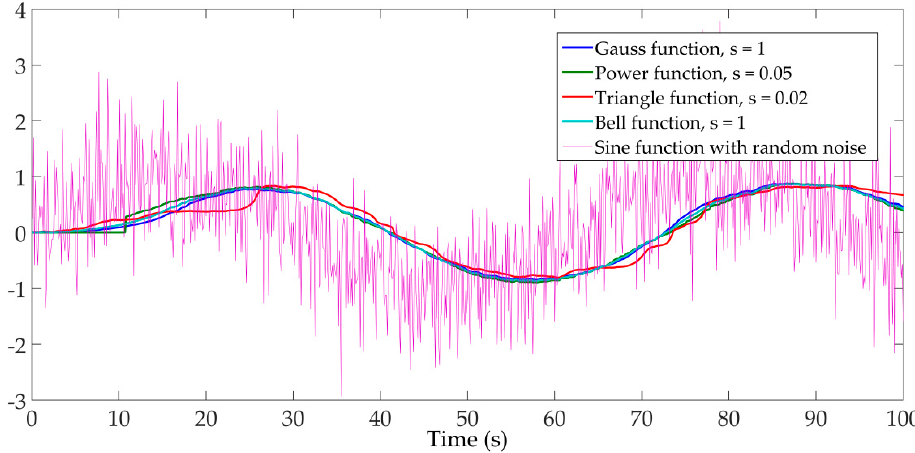
Figure 8. Comparison of using different membership functions for filtration of sine function with random noise.